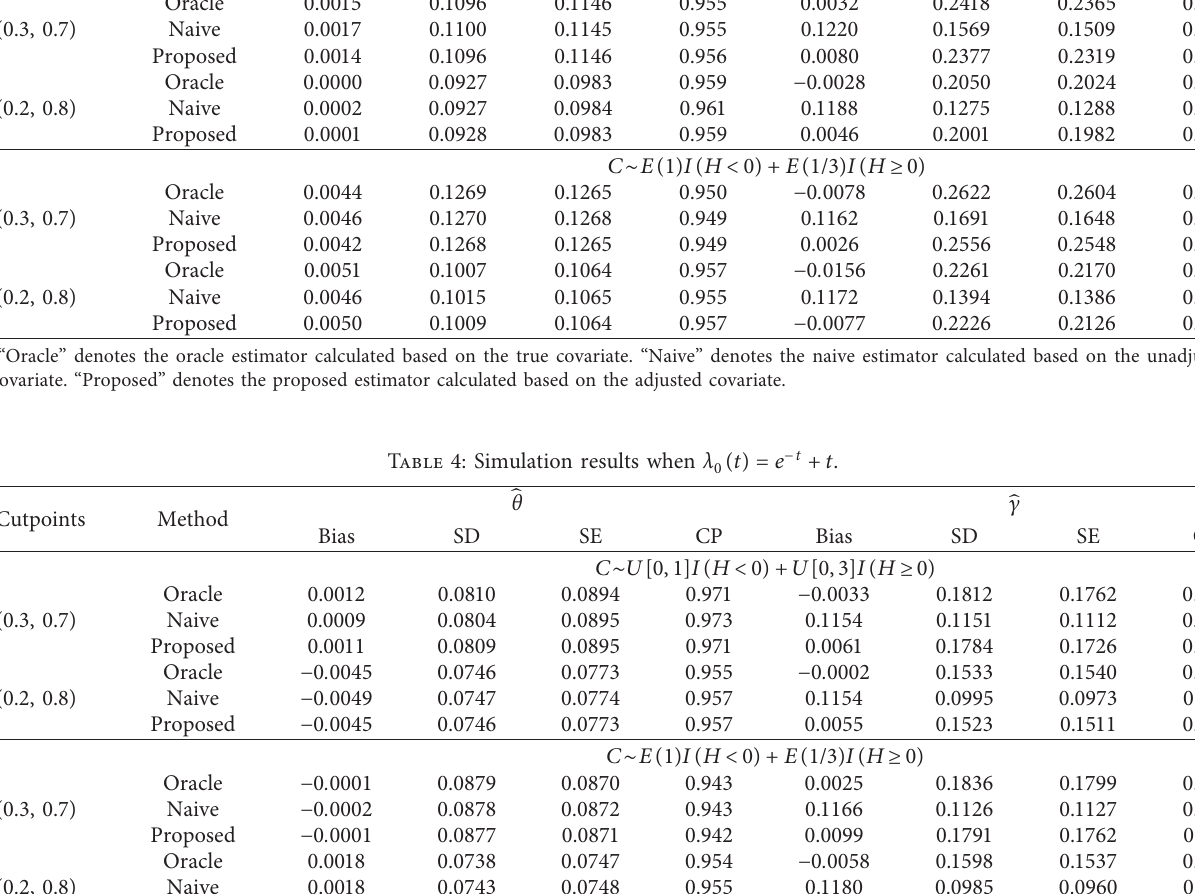
Table 3: Simulation results when λ